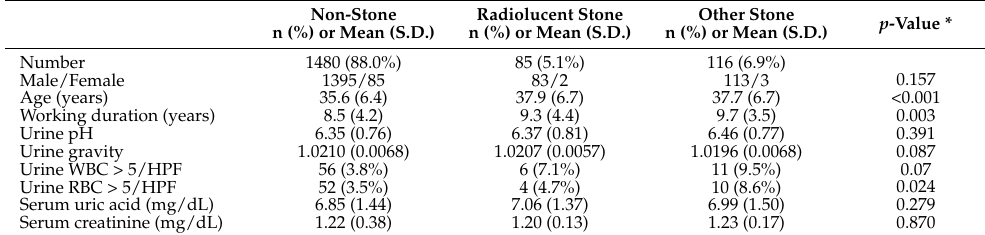
Table 1. Frequency distribution and ANOVA tests of the non-stone, radiolucent stone, and other stone groups by age, work years, urine pH, urine gravity, urinary WBC, urinary RBC, serum uric acid, and creatinine. Non-Stone Radiolucent Stone Other Stone n (%) or Mean (S.D.) n (%) or Mean (S.D.) n (%) or Mean